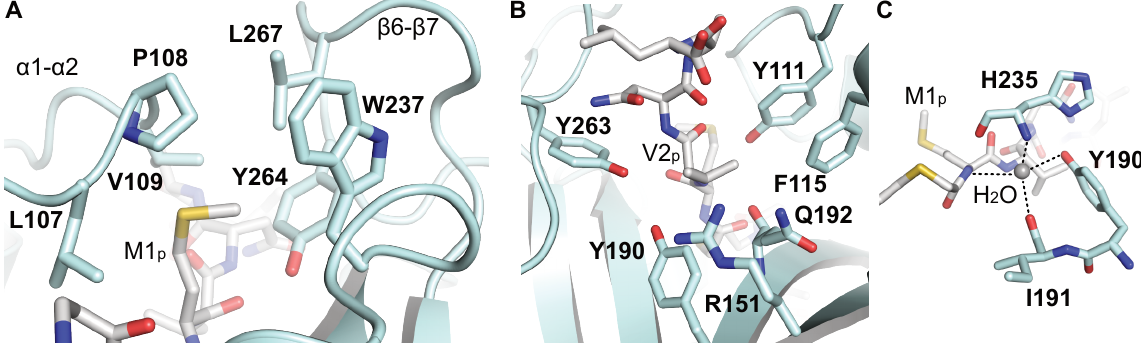
Figure 6. Ct Naa50 82-289 active site and substrate peptide binding. ( A ) M1 p resides in a hydrophobic pocket formed by residues in loops α 1– α 2 (L107, P108, and V109), β 6– β 7 (Y264 and L267), and β 5 (W237). ( B ) The second peptide residue, V2 p , sits in an amphiphilic pocket formed by Y111, F115, R151, Y190, Q192, and Y263. ( C ) The active site contains a catalytically important water molecule, which is bound by the amide group of M1 p , Y190 hydroxyl, I191 main-chain carbonyl, and H235 main-chain amide groups. Structural details of the active site are shown in the ribbon representation in light blue with residues shown in stick representation. The Q192 main-chain carbonyl group in β 4 and the Y111 hydroxyl group in loop α 1– α 2 form hydrogen bonds with the substrate V2 p main-chain amide and carboxyl groups, respectively. V2 p is partly solvent-exposed and resides in an amphiphilic pocket